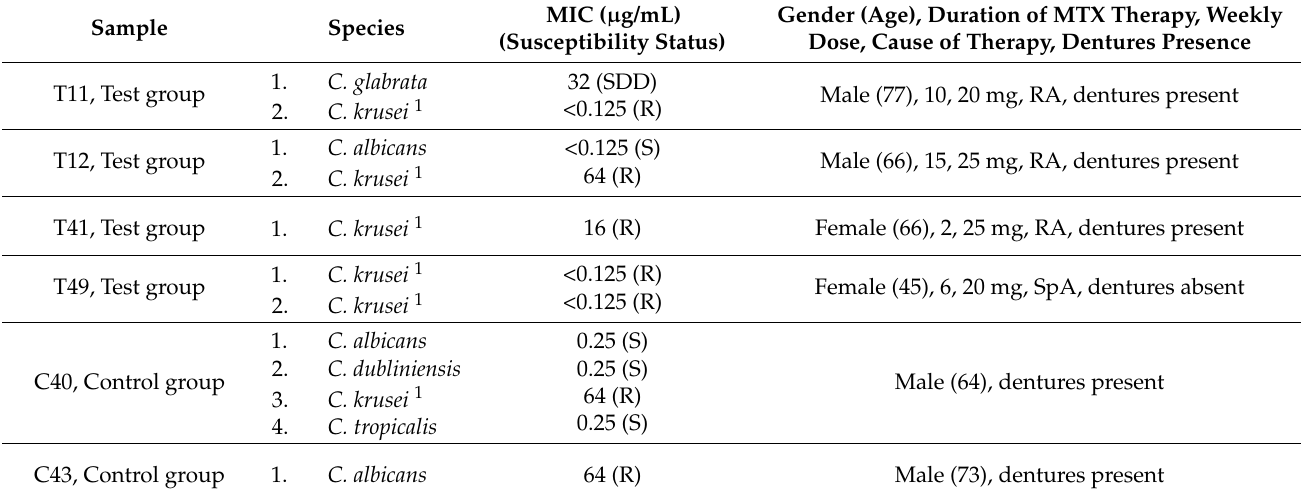
Table 4. Characteristics of samples containing Candida strains showing resistance (R) to fluconazole. S—fluconazole-sensitive strain, SDD—dose-dependent sensitivity, RA—Rheumatoid arthritis, SpA—spondyloarthritis.